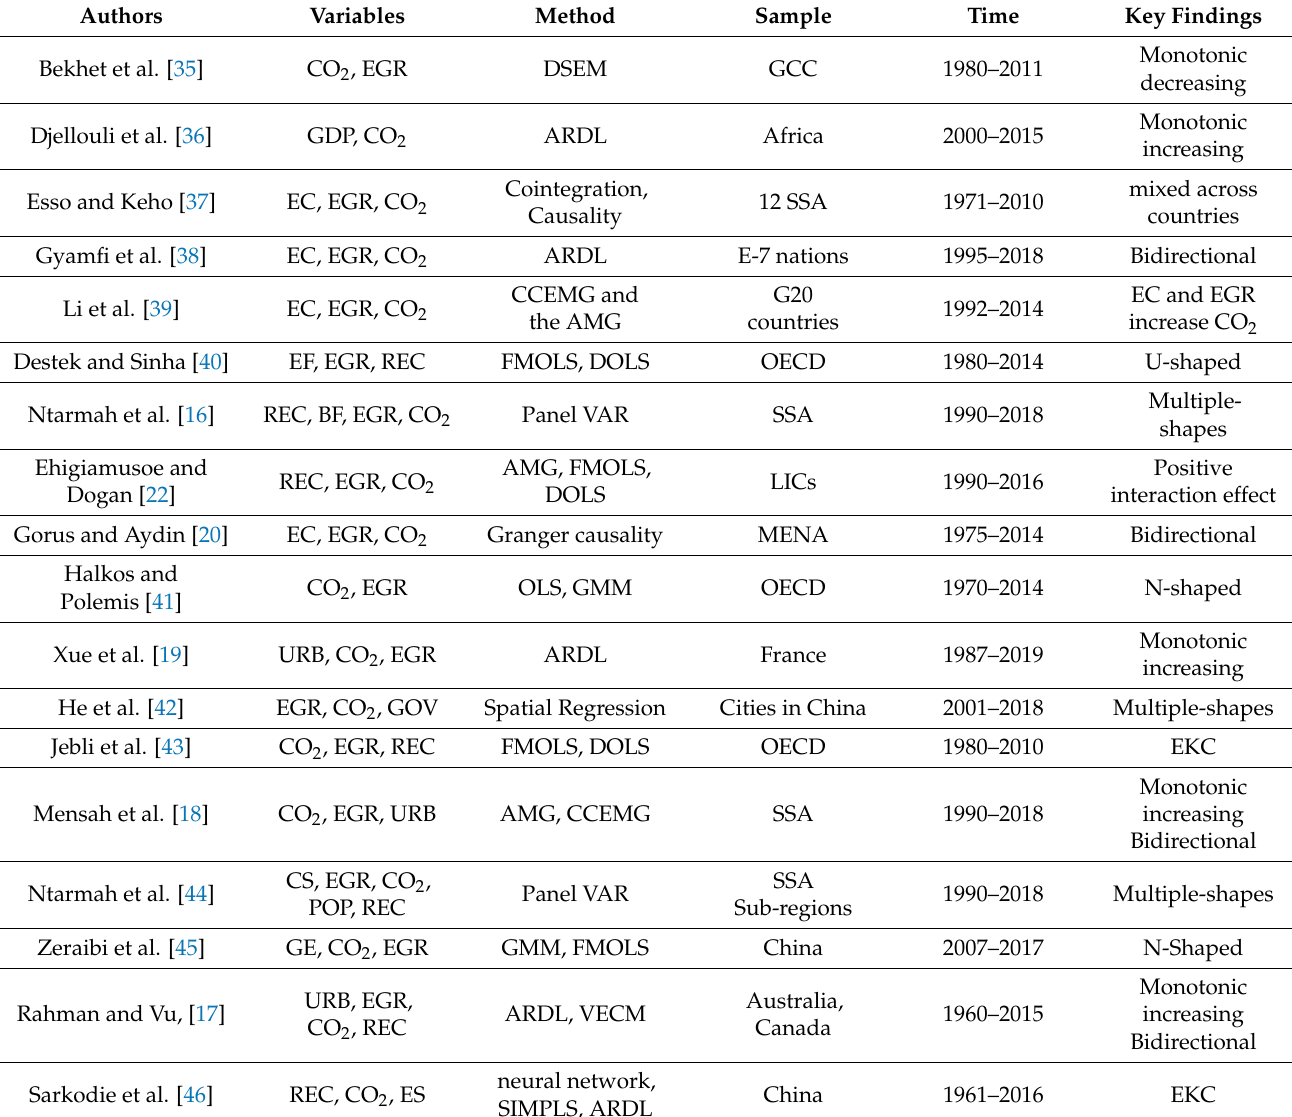
Table 1. Summary of Environmental Literature.